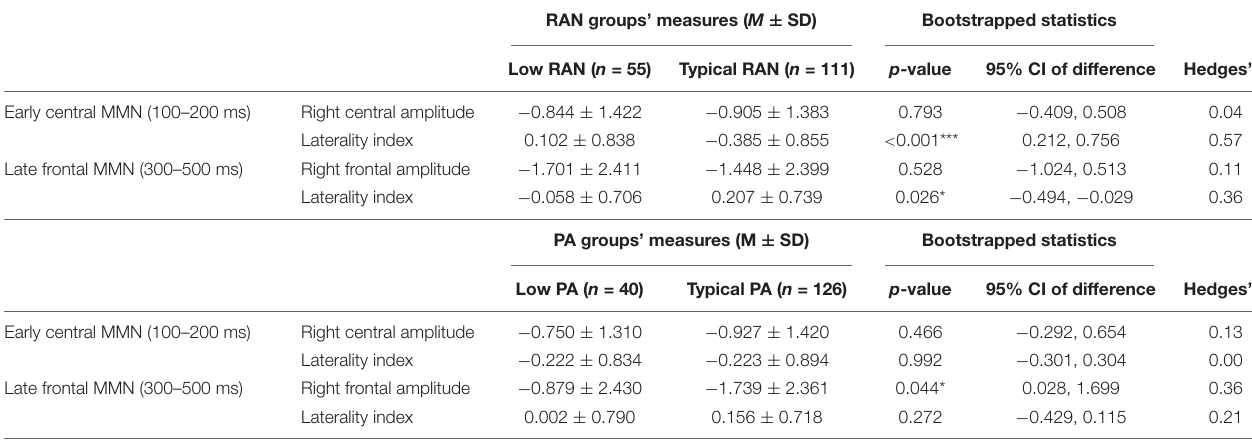
TABLE 2 | Early and late MMN measurements and group comparisons for Low and Typical RAN and PA